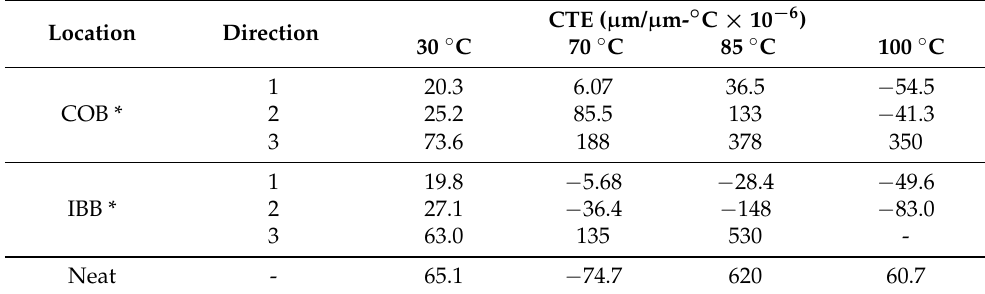
Table 8. CTE values for GF/PETG and PETG ( T g = 77–78 ◦ C).